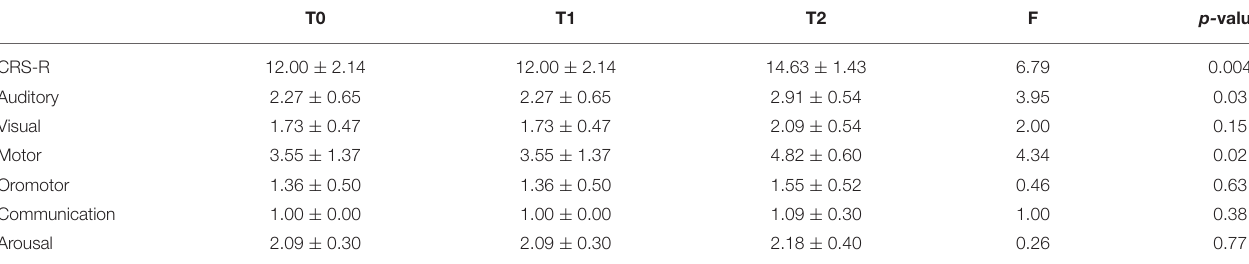
TABLE 2 | CRS-R total and subscales scores of the 11 patients with minimally conscious state (MCS) at each time